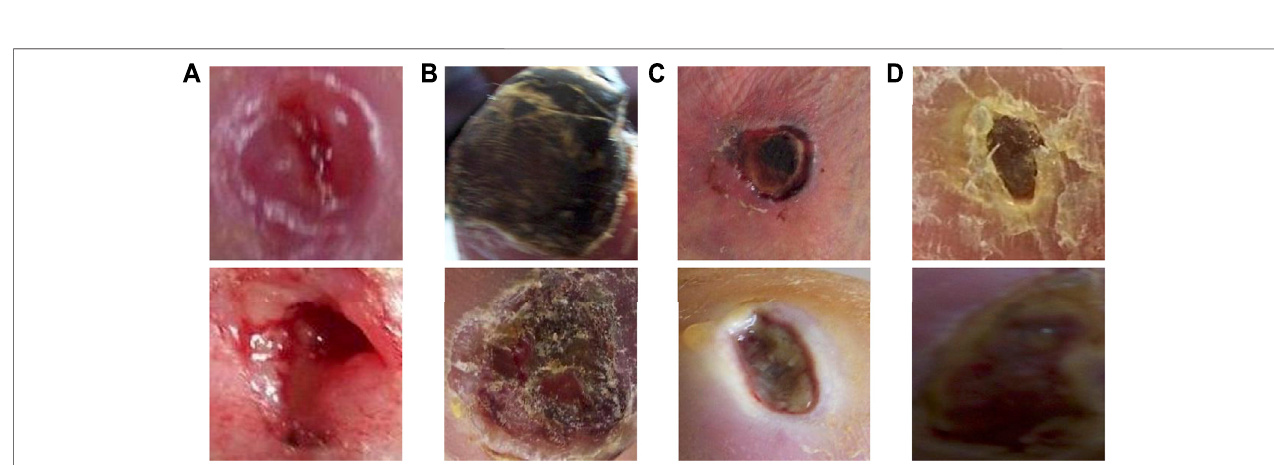
FIGURE8| Examplesofclassi fi cation results oftheproposedmethodonthe ischaemia dataset. (A) true negative cases, (B) true positivecases, (C) false negative cases and (D) false positive cases.